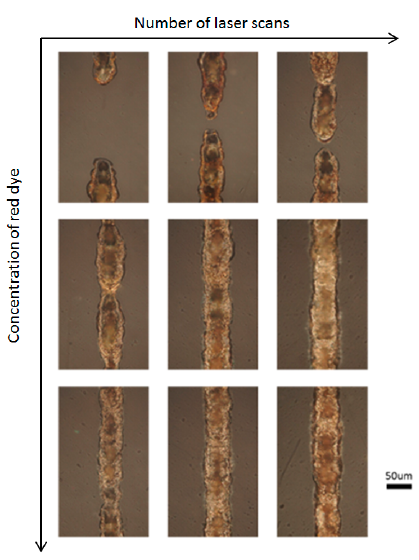
Figure 3. Silver lines fabricated by the LDSP process on the polyethylene terephthalate (PET) substrate with different numbers of laser scans: 10×, 20×, 30× and red-dye concentrations in the process solution of 4 mM, 8 mM, and 16 mM.